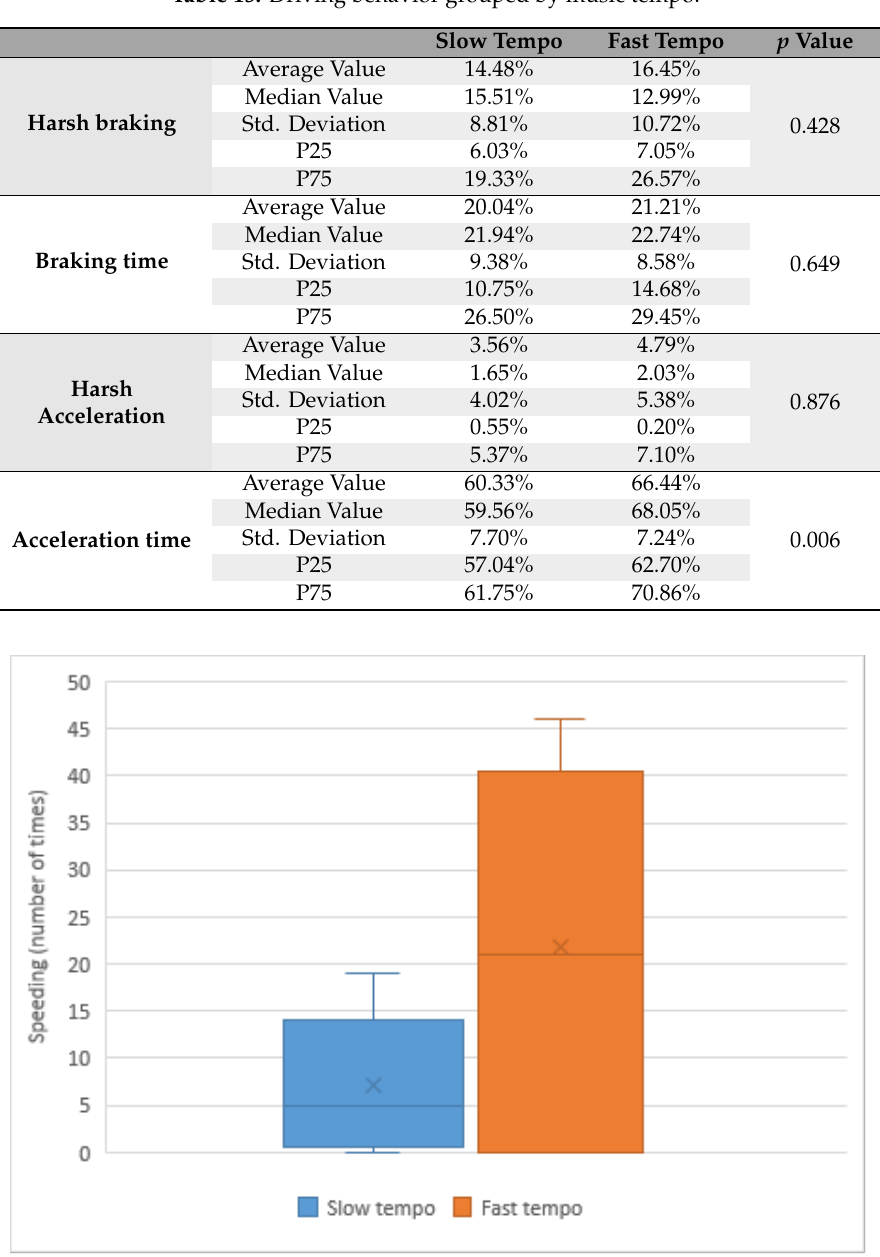
Table 15. Driving behavior grouped by music tempo.